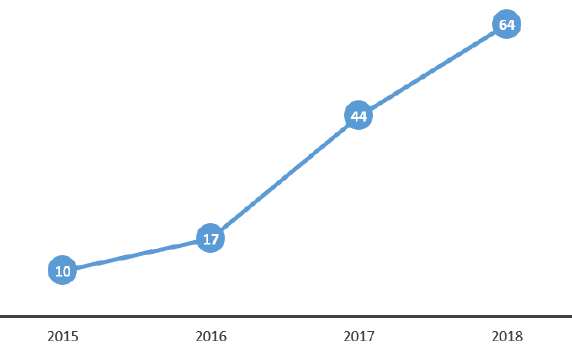
Figure 2. Number of publications with terms UAV or drone detection and/or classification in their title since 2015 based on Google scholar